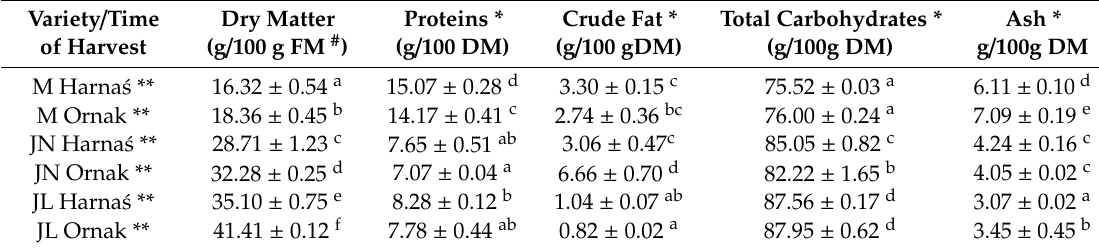
Table 1. Proximate analysis of whole plants of garlic grown from air bulbils. Variety /